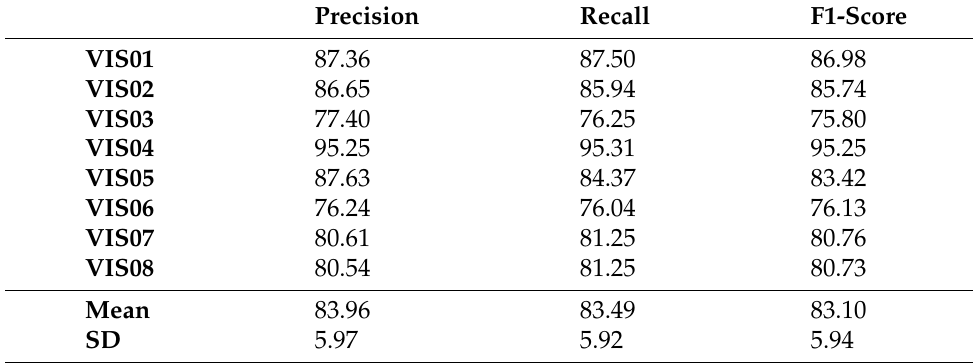
Table 2. Classifier performance (in %) of VIS group with optimal transport.